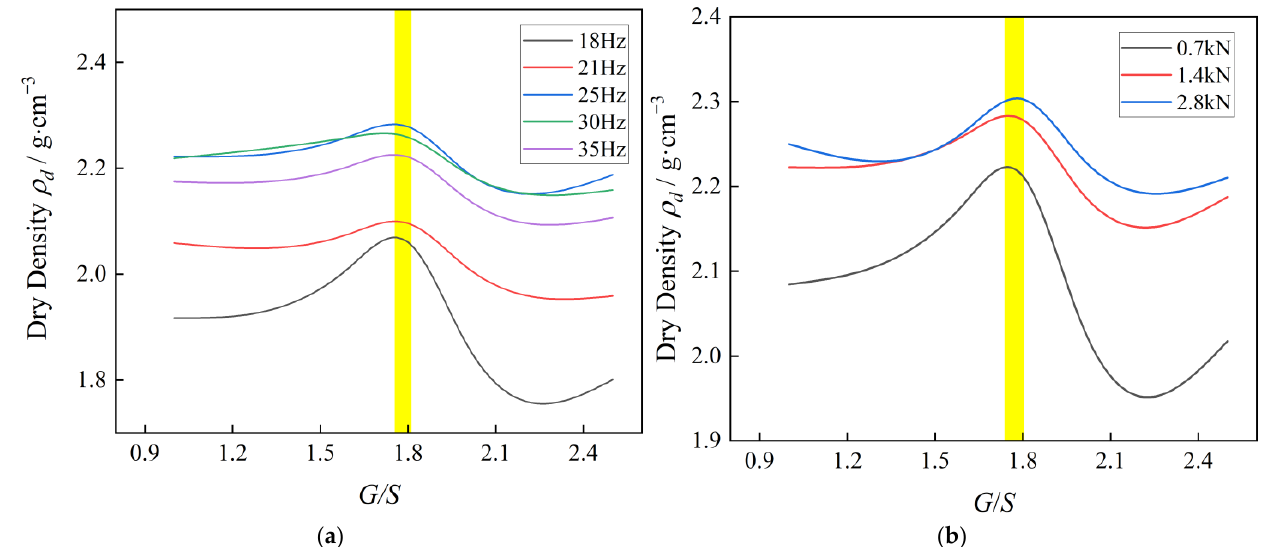
Figure 9. The curves of achieved dry density versus G/S value from laboratory plate vibratory compaction tests conducted at ( a ) fixed vibratory force (1.4 kN) but different vibratory frequency levels and at ( b ) fixed vibratory frequency (25 Hz) but different vibratory force levels.